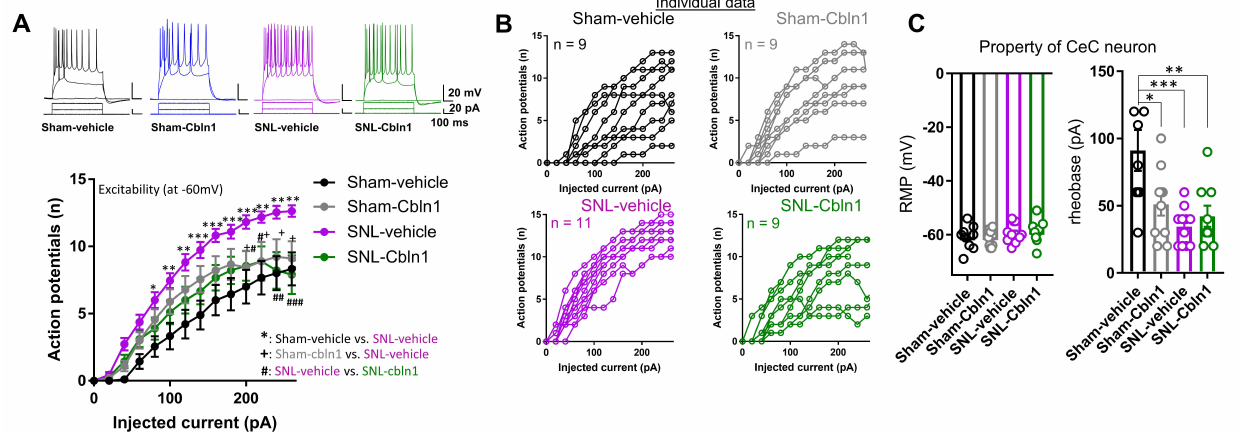
Figure 7. Recombinant Cbln1 rescues hyperexcitability of CeC neurons in the neuropathic pain model. ( A ) Recombinant Cbln1 reduced hyperexcitability (F-I relation) in CeC neurons in brain slices from SNL rats. Current clamp recording from CeC neurons with membrane potential set at -60 mV. Current injections were performed to generate action potentials. SNL increased the excitability and Cbln1 was able to rescue hyperexcitability in SNL model (Two-way repeated measures ANOVA, treatment F (3, 34) = 5.6, p = 0.003, Tukey’s multiple comparison, SNL-vehicle ( n = 11 neurons from 5 rats) vs. Sham-vehicle ( n = 9 neurons from 4 rats): 80 pA p = 0.026, 100 pA p = 0.0045, 120 pA p = 0.0011, 140 pA p = 0.0005, 160 pA p = 0.0005, 180 pA p = 0.0009, 200 pA p = 0.0005, 220 pA p = 0.0014, 240 pA p = 0.0013, 260 pA p = 0.0027; SNL-vehicle vs. SNL-Cbln1 ( n = 9 neurons from 5 rats): 200 pA p = 0.039, 220 pA p = 0.037, 240 pA p = 0.0025, 260 pA p = 0.0007; Sham-Cbln1 ( n = 9 neurons from 5 rats) vs. SNL-vehicle: 200 pA p = 0.031, 220 pA p = 0.037, 240 pA p = 0.034, 260 pA p = 0.021). ( B ) Excitability of individual cells in various Sham and SNL, control and Cbln1 groups. Note the reduced variance of individual cell excitability in SNL rats compared to other groups. ( C ) Property of CeC neurons under